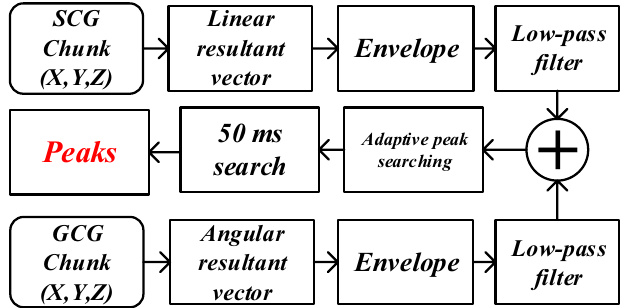
Figure 4. Peak detection technique based on envelope detection.